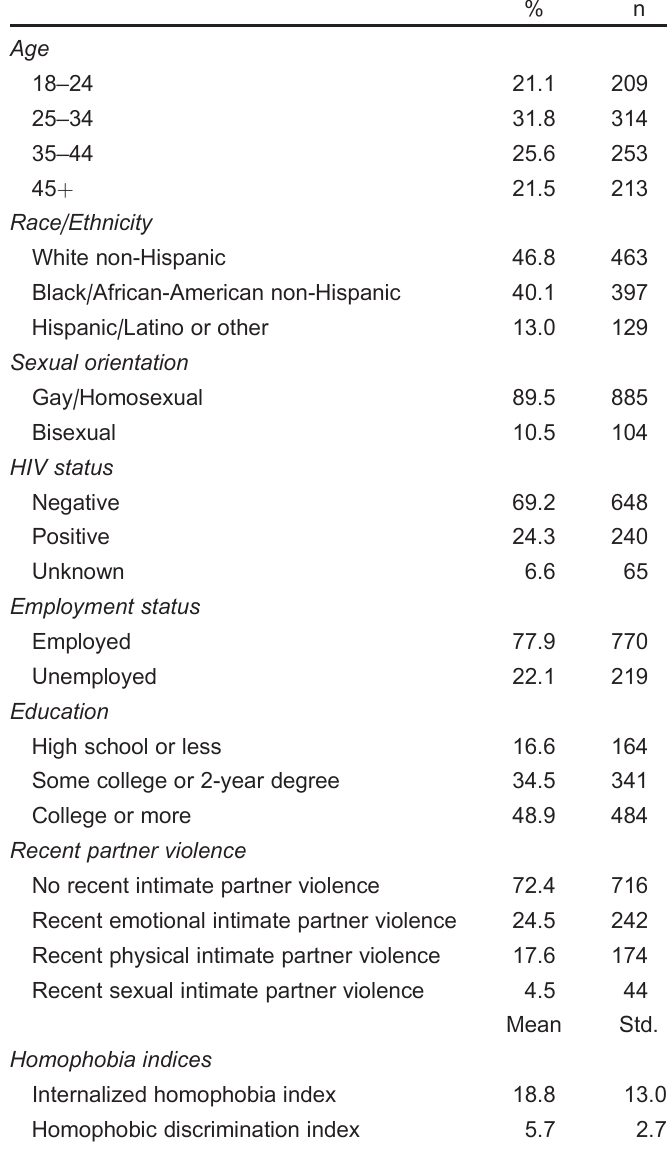
Table 1. Sample characteristics of survey participants (n ¼